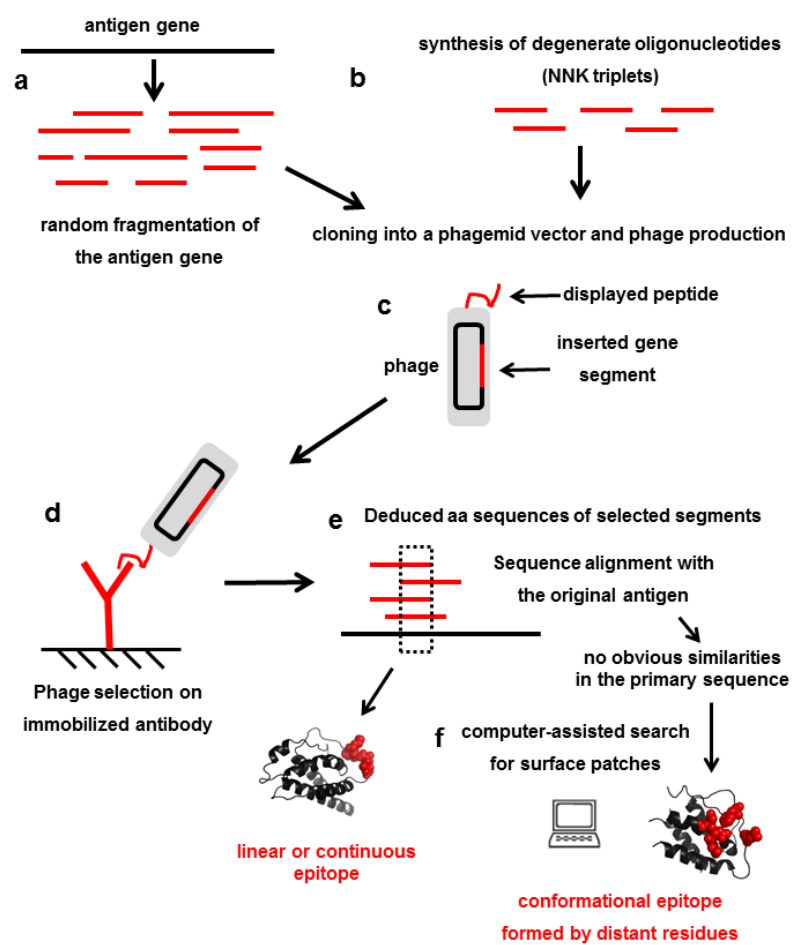
Figure 1. Epitope identification using libraries of antigen fragments or random peptides. ( a ) Generation of fragments from the antigen gene. ( b ) Synthesis of short segments of DNA encoding random peptides. ( c ) Cloning of antigen gene-derived/random DNA segments in suitable phagemid vectors and production of phages displaying the corresponding peptides. ( d ) Selection of phages displaying peptides that are recognized by the antibody under investigation. ( e ) Sequencing of the inserted DNA fragments from selected phagemids, deduction of peptide sequences, and alignment with the whole protein sequence of the antigen, allow direct identification of the antigen segment that is recognized (linear or continuous epitope). ( f ) If there is no obvious similarity between the isolated peptide ligands and the antigen, peptides can resemble a cluster of amino acids in the antigen 3D structure. In these cases, the conformational or discontinuous epitope is located through computer-assisted exploration of the antigen surface.